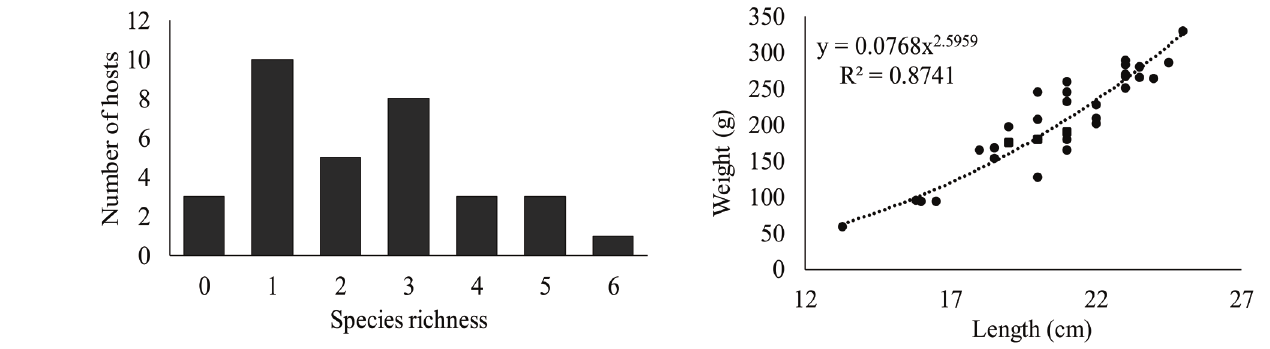
Figure 2 - Species richness of parasites in Astronotus ocellatus from the Fortaleza Igarapé basin, in eastern Amazon (Brazil).